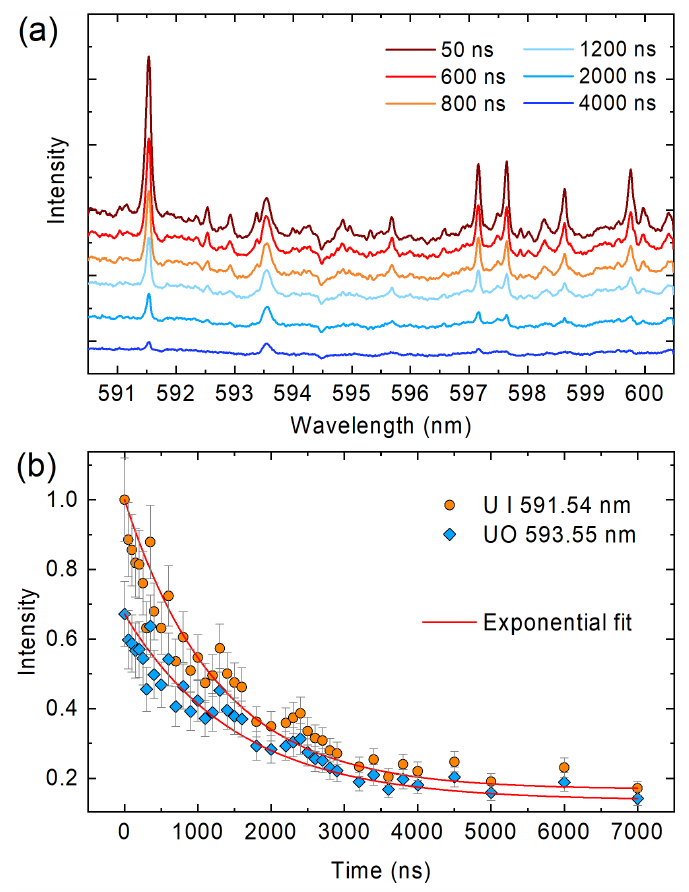
Figure 6. ( a ) Time-resolved evolution of uranium spectrum recorded with a quadratic phase application of − 900 fs 2 . ( b ) Intensity of atomic (U I 591.54 nm) and molecular (UO 593.55 nm) uranium laser-produced plasma (LPP) emission for the emission features shaded in ( a